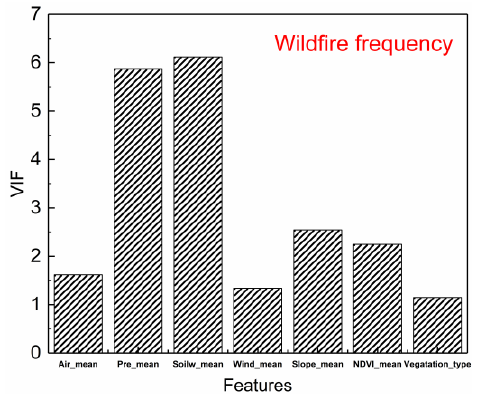
Figure 10. VIF values for the seven drivers on the annual frequency of bushfires.